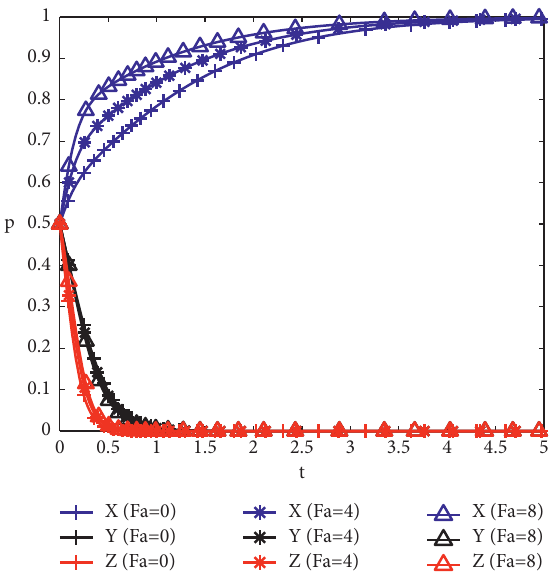
Figure 8: Evolution path under different